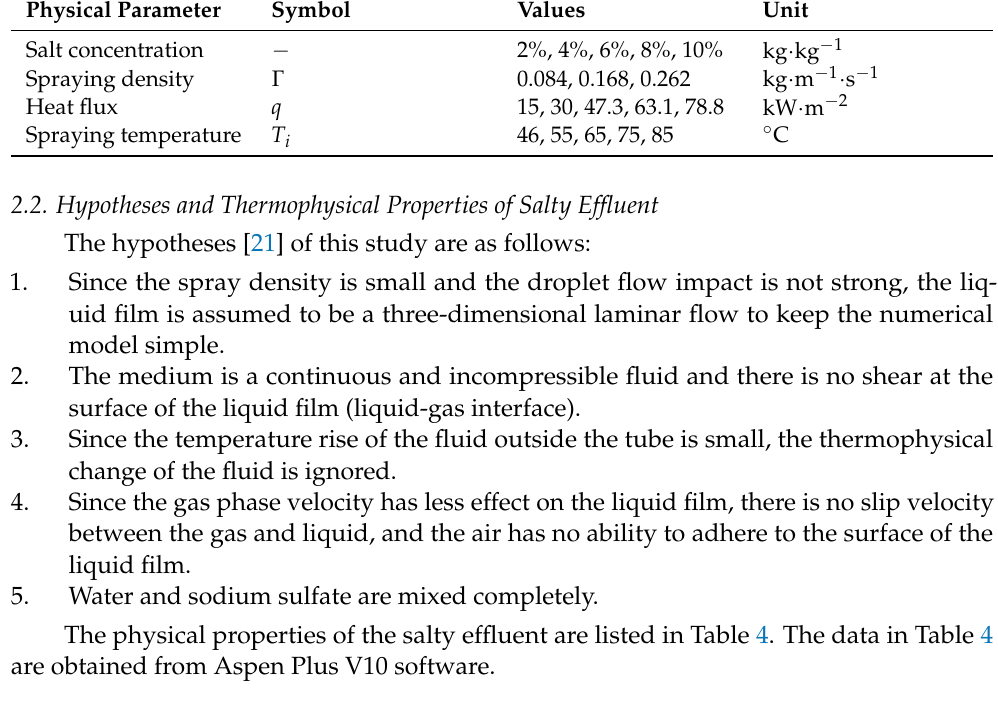
Table 4. Physical properties of salty